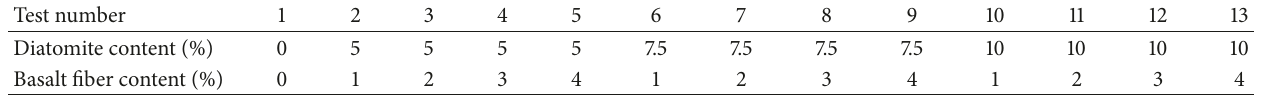
Table 4: Contents of diatomite and basalt